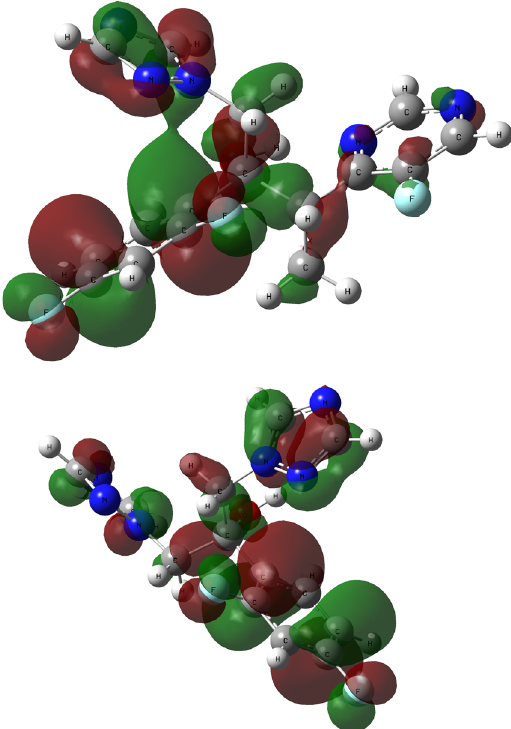
Figure 8: The HOMO orbitals generated for compound 1 ( up ; rotamer optimized at the PBE1BE/6 - 31G ( d,p ) level of theory in methanol ) and 2 ( down ; rotamer optimized at the B3LYP/6 - 31G ( d,p ) level of theory in methanol ) ; vertical excited states calculated at the functional/6 - 311 ++ G ( 2d,3p ) level of theory ( functional: PBE1BE or B3LYP for 1 or 2 , respectively ) .